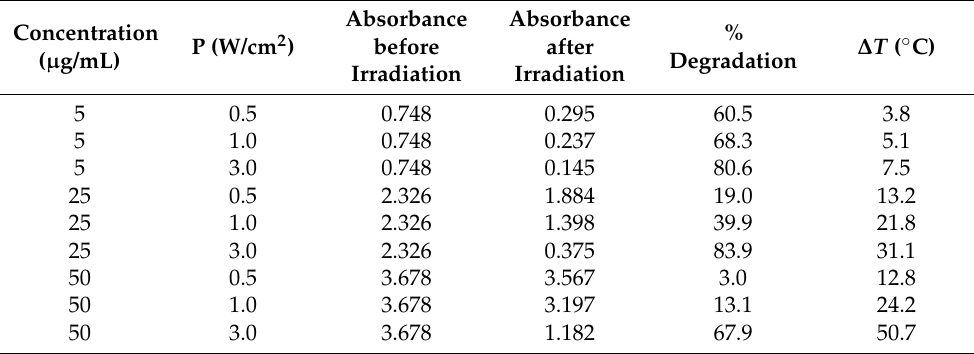
Table 1. Calculated absorbance decrease after irradiation with 808 nm laser (P = 0.5, 1, and 3 W/cm 2 ) of ICG solutions in PBS. An increase in temperature ( ∆ T ) was calculated by subtracting the initial temperature ( t = 0 s) from the maximum temperature reached.